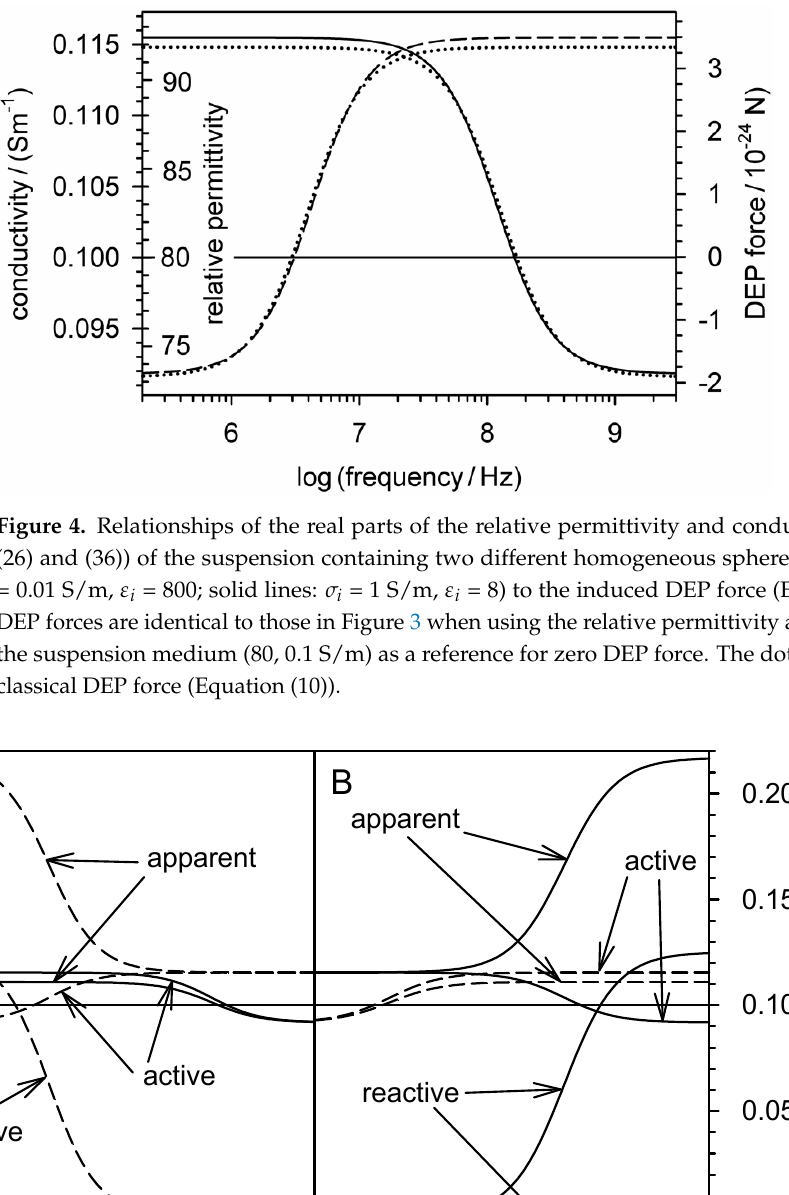
σ ε σ = 0.01 S/m, i = 800; solid lines: i